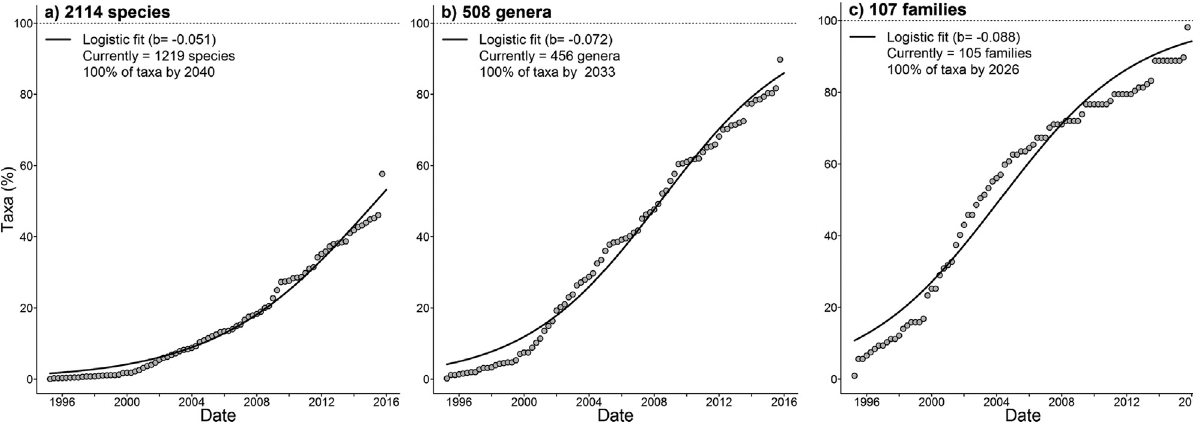
Figure3 -Increaseofthenumberof(a)species,(b)generaand(c)familiesacrosstimewithrespecttothetenDNAmarkersconsideredinthisstudy.Bold linesarethebestfitofthelogisticfunctiontotheaccumulatednumberofsequencesortaxa.DashedlinesarethetotaloftaxaintheSPtreeflora.Datesare aggregated in trimesters and the fit of functions to the accumulated number of taxa was carried out only from mid 1995